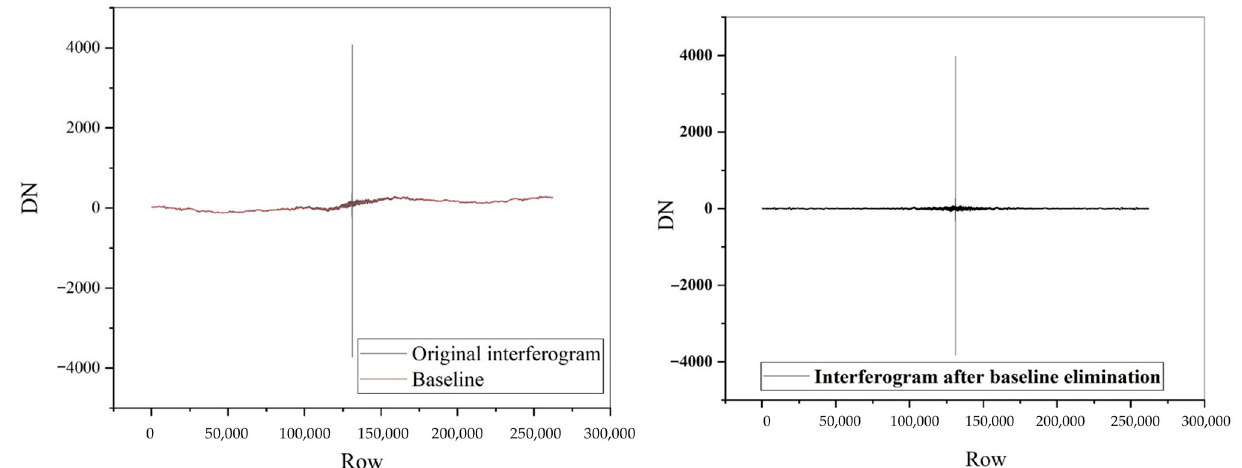
Figure 13. Effect Picture of Interferogram Baseline Correction.